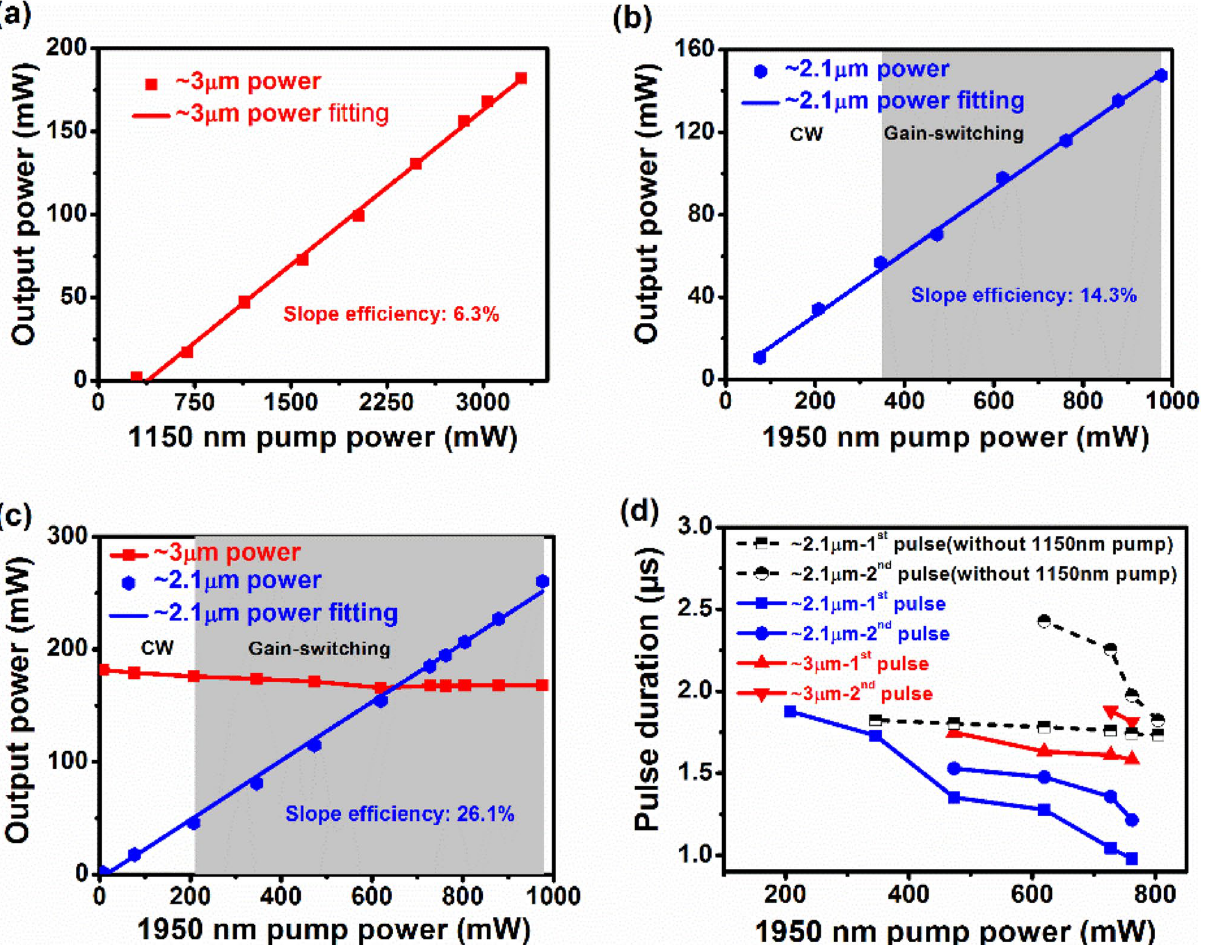
Figure 4. ( a ) ~ 3 μm CW output power with CW pump power at 1150 nm, without 1950 nm pulsed pump. ( b ) ~ 2.1 μm output power with pulsed pump power at 1950 nm, without 1150 nm CW pump. ( c ) ~ 3 μm and ~ 2.1 μm output power with pulsed pump power at 1950 nm and fixed pump power of 3.295 W at 1150 nm. ( d ) Variations of pulse duration at ~ 3 μm and ~ 2.1 μm in different pumping corresponding to blue and red shifting of the spectra, respectively. Such red (blue) shifting of spectrum is equiva- lent to a decrease (increase) in wave frequency and photon energy. The corresponding wavelengths blue- and red-shifted from 2062.27 nm to 2061.65 nm and from 2909.4 nm to 2910.16 nm with increasing the 1950 nm pump power from 8 mW to 975.36 mW, respectively. This is because the initial and terminal Stark manifolds of the 5 I 7 → 5 I 8 and 5 I 6 → 5 I 7 transitions are upshifted, as induced by the accumulated population in the 5 I 7 level when the pump power is increased, hence leading to shorter and longer wavelength emissions. These phenomena of red and blue shifting coincide with the processes of laser transitions and have been theoretically and experi- mentally verified in Er 3+ - and Ho 3+ -doped fluoride fiber lasers 36–40 . Note that the wavelengths could be adjusted by changing the pump power albeit with the narrow adjustable ranges of 0.62 nm and 0.76 nm for the ~ 2.1 µm and ~ 3 µm pulses, respectively. However, the narrow adjustable ranges are mainly limited by the pump power of our pump source. The output powers of the Ho 3+ -doped ZBLAN fiber laser in different pumping schemes are depicted in Fig. 4a–c. Figure 4a shows the output power of the ~ 3 μm CW laser as a function of the 1150 nm pump power. It is observed that the output power increases almost linearly with the increased 1150 nm pump power at a slope efficiency of 6.3%. The maximum output power of the ~ 3 μm CW laser is 181.85 mW at the 1150 nm pump power of 3.295 W. For the case of using only the 1950 nm pulsed pump source, the output power of the ~ 2.1 μm laser has the same variation trend as the ~ 3 μm CW laser with increasing the 1950 nm pump power at a slope efficiency of 14.3%, as shown in Fig. 4b. The output power of the ~ 2.1 μm gain-switched pulsed laser increases from 56.72 to 147.63 mW with increasing the 1950 nm pump power from 346.17 to 975.36 mW. Figure 4c shows the output power of the dual-waveband fiber laser as a function of the 1950 nm pump power when the 1150 nm pump power was fixed at 3.295 W. It is seen that the output power of the ~ 3 μm laser slightly decreases from 181.85 to 165.82 mW with increasing the 1950 nm pump power from 0 to 619.5 mW and then maintains at ~ 167.7 mW. The results indicate that the output power of the ~ 3 μm laser is mainly dependent on the 1150 nm pump power. The output power of the ~ 2.1 μm laser increases almost linearly from 1.59 to 260.27 mW with increasing the